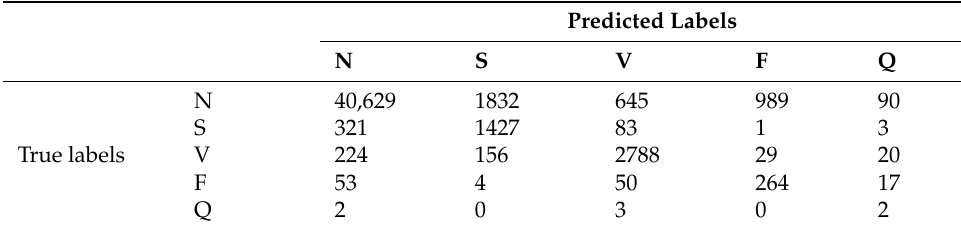
Table 6. Confusion matrix for the inter-patient paradigm.